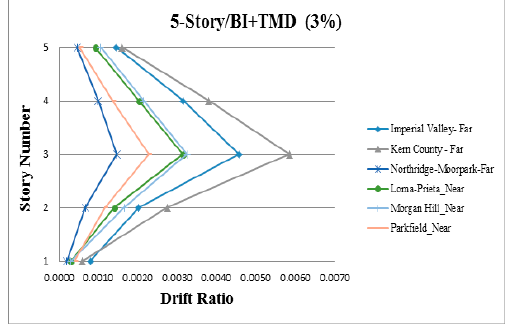
Figure A29. Drift ratios for 5-story base-isolated building with 1 TMD.